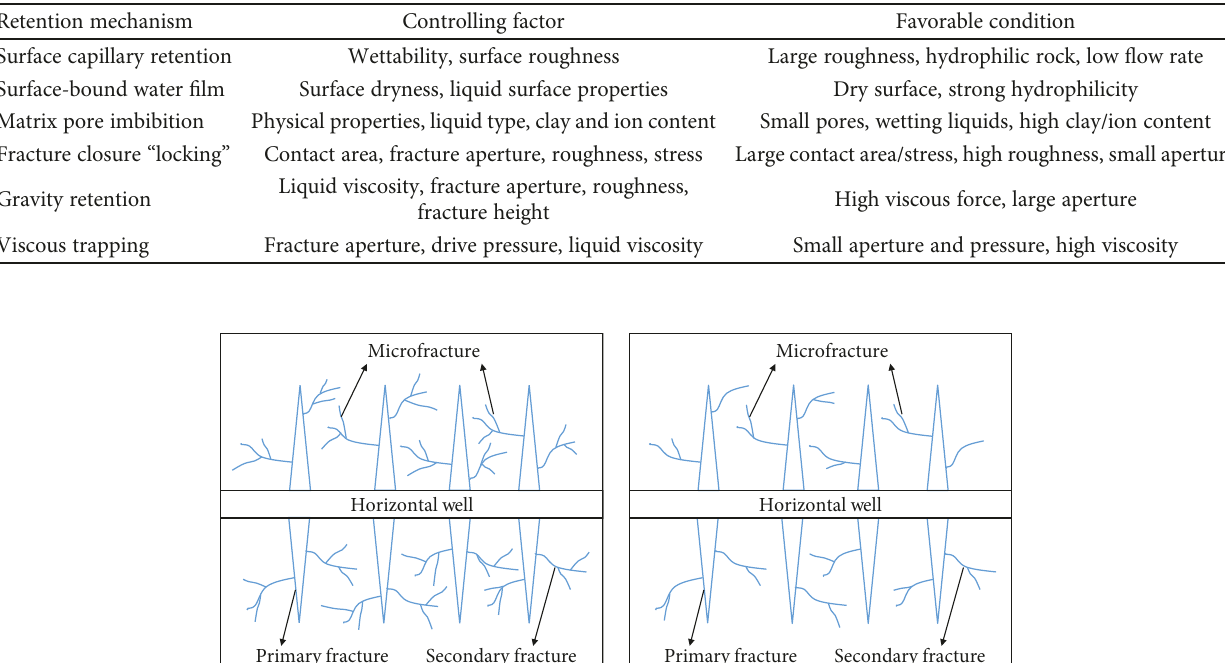
Table 5: FFR mechanisms.